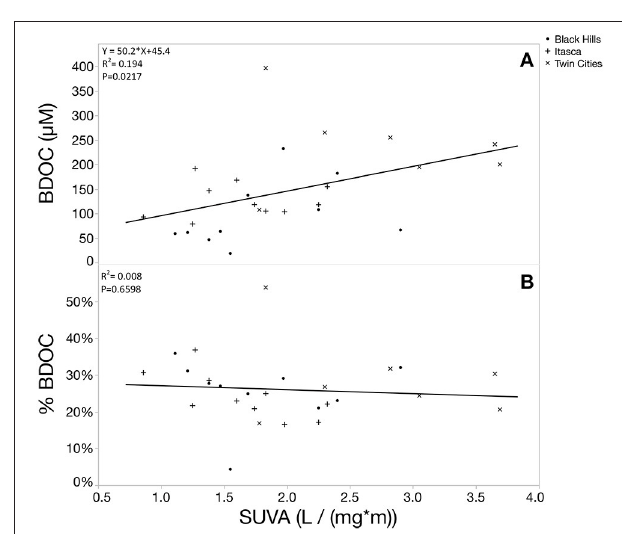
FIGURE 9 | Scatterplots showing the relationship between BDOC and SUVA. Panel (A) shows the absolute size of the BDOC pool and (B) shows the relative size of the BDOC pool. The absolute amount of BDOC showed a significant positive association with SUVA whereas the relative BDOC percentage was not significantly related to SUVA. This could be at least partially driven by the fact that high SUVA systems tend to have larger total DOC pools, but it also suggests that systems dominated by more aromatic carbon compounds (high SUVA) still have large pools of